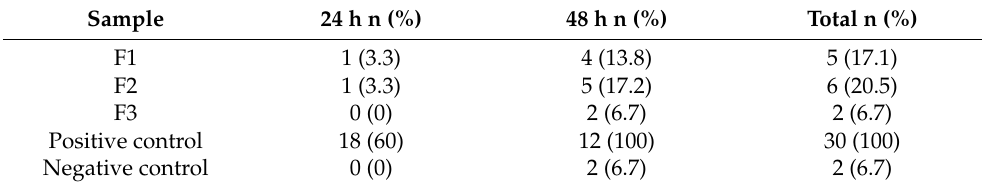
Table 2. Dead larvae (n) and mortality percentage (%) of A. salina per sample at 24 and 48 h. Sample